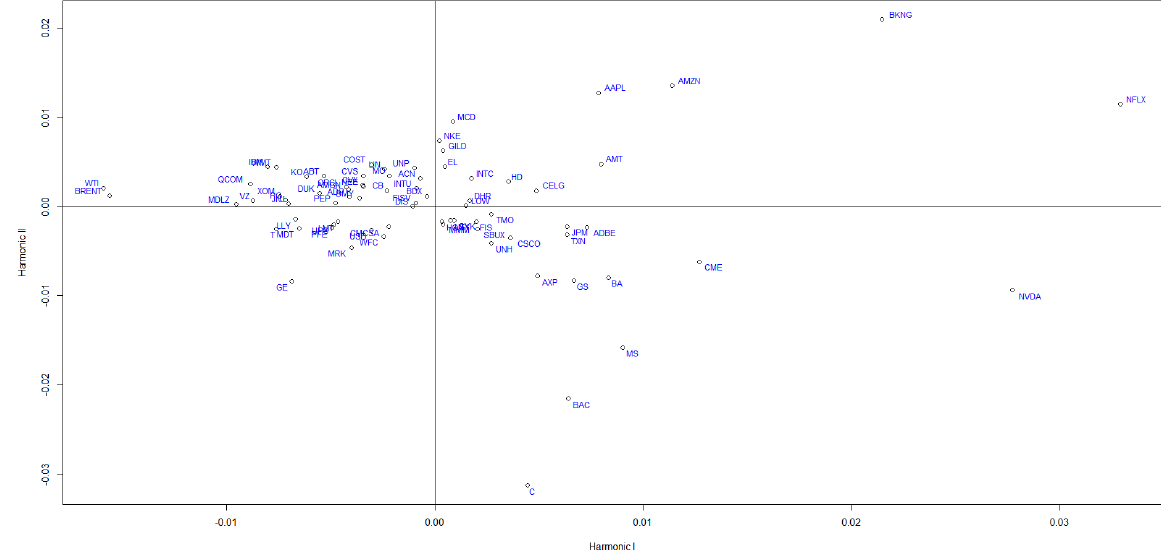
Figure 4. The 2D FPCA. Note: Harmonic I: 1st component; Harmonic II: 2nd component.